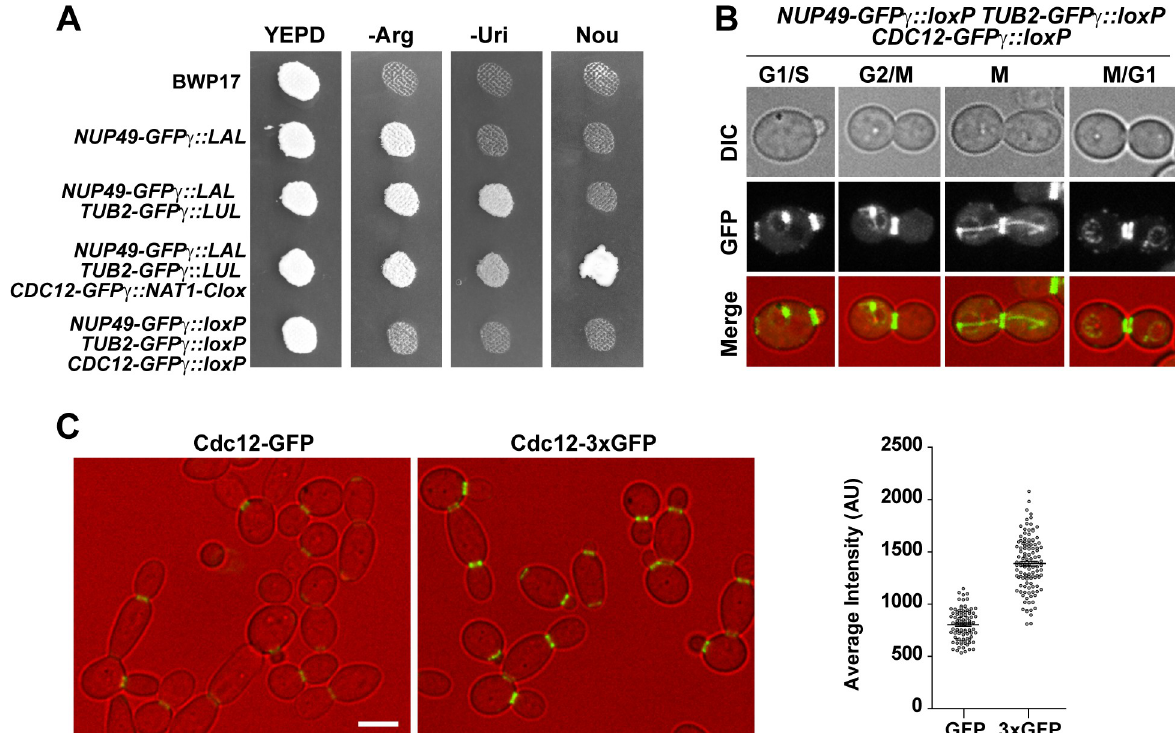
Fig 3. Generation of auxotroph strains containing three genes tagged with GFP γ . (A) Growth in selective media. Single colonies of strains BWP- 17, NUP49-GFP γ :: LAL/NUP49 (OL2845), NUP49-GFP γ :: LAL/NUP49 TUB2-GFP γ :: LUL/TUB2 (OL2847), NUP49-GFP γ :: LAL/NUP49 TUB2-GFP γ :: LUL/TUB2 CDC12-GFP γ :: NAT1-Clox/CDC12 (OL2867) and the resolved strain NUP49-GFP γ :: loxP/NUP49 TUB2-GFP γ :: loxP/TUB2 CDC12-GFP γ :: loxP/CDC12 (OL2866) were grown on YPD plates and replica-printed to -Arg, -Uri and YPD + nourseothricin media. Plates were incubated 2 days at 28 º C. (B) Images of cells carrying Nup49-GFP γ , Tub2-GFP γ and Cdc12-GFP γ during yeast growth. Exponential growing cultures of the NUP49-GFP γ :: loxP/NUP49 TUB2-GFP γ :: loxP/TUB2 CDC12-GFP γ :: loxP/CDC12 strain (OL2866) were imaged. The images are the maximum projection of 5 planes and show the differential interference contrast image (DIC), the GFP channel and the merged image (DIC in red, GFP in green). Scale bar, 2 μ m. (C) Comparison of GFP γ and 3xGFP γ intensity. Images of CDC12-GFP γ :: LAL/CDC12 or CDC12-3xGFP γ :: LAL/ CDC12 cells during yeast growth. The images are the maximum projection of 3 planes and show the differential interference contrast image (DIC, in red) and the GFP signal (green). Scale bar, 2 μ m. The graph represents the average intensity of the signal ± s.e.m. in both strains. At least 50 single rings were measured in each